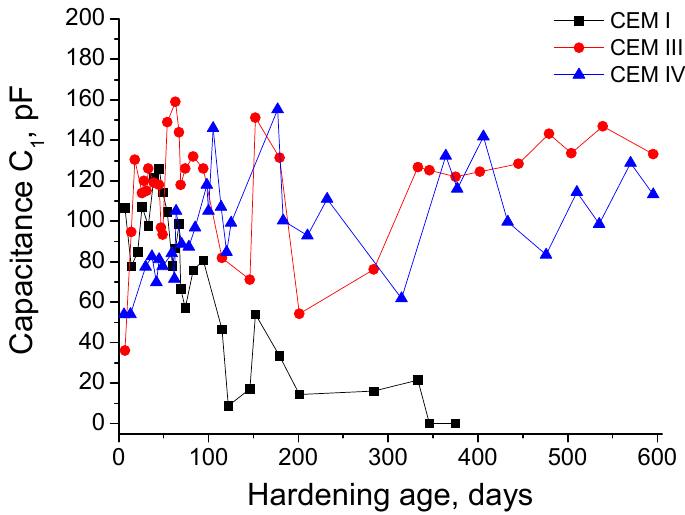
Figure 4. Impedance capacitance C 1 results for CEM I, CEM III and CEM IV grouts.